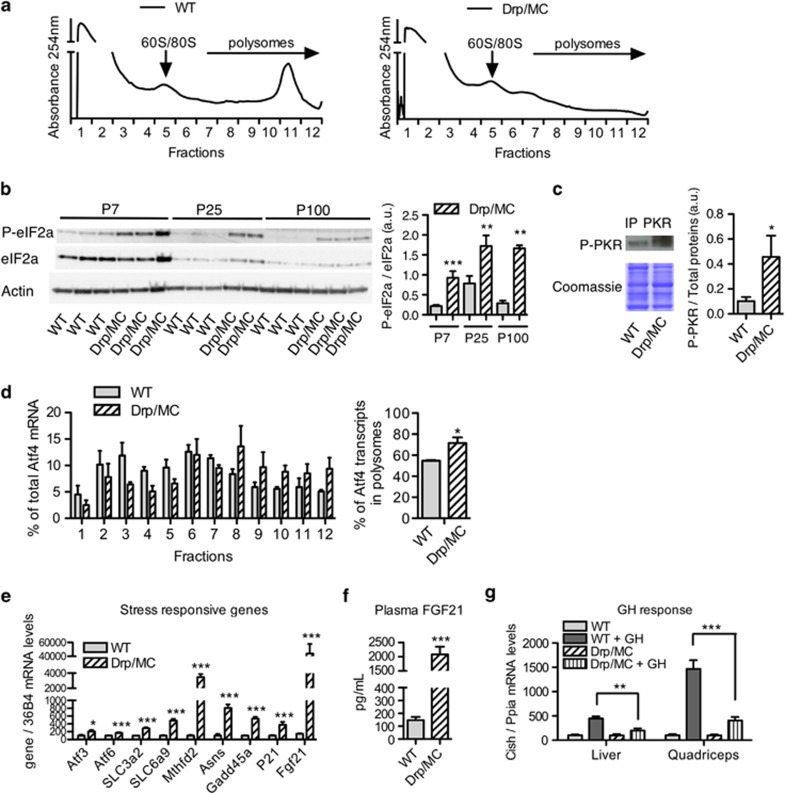
eIF2α/Atf4 pathway is activated in Drp/MC muscle. (a) Polysome profile in quadriceps from young (P40) WT and Drp/MC mice. Lysates were analysed by centrifugation in a 10–50% sucrose gradient, and the profiles were measured by absorbance at 254 nm. The panel is representative of three independent experiments. (b) Representative western blot analysis of phosphorylated and total eIF2α protein expression levels in quadriceps from P7, P25 and adult (P100) WT and Drp/MC mice. Quantification is given in the right chart (n=5 per genotype). (c) Western blot analysis of phosphorylated PKR protein levels after immunoprecipitation of total PKR protein from gastrocnemius protein lysate of adult (P100) WT and Drp/MC mice (n=3 per genotype). (d) Atf4 mRNA distribution in the fractions collected from the sucrose gradients was determined by RT-qPCR. Percentage of Atf4 transcripts present in polysomal fractions (6–12) (n=3 per genotype). (e) RT-qPCR analysis of representative stress-response genes mRNA levels in quadriceps from adult WT and Drp/MC mice (n=8 per genotype). (f) Plasma levels of Fgf21 in adult WT and Drp/MC mice (n=11 per genotype). (g) RT-qPCR analysis of Cish mRNA levels in quadriceps from adult WT and Drp/MC mice 4 h after GH treatment (1.5 mg/kg i.p., n=7 per group). Error bars represent S.E.M. *P<0.05, **P<0.01, ***P<0.001 versus WT